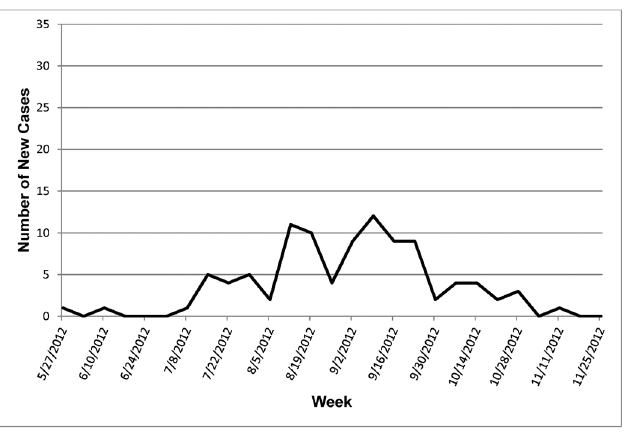
Fig 4. Number of new EHD cases in captive white-tailed deer by